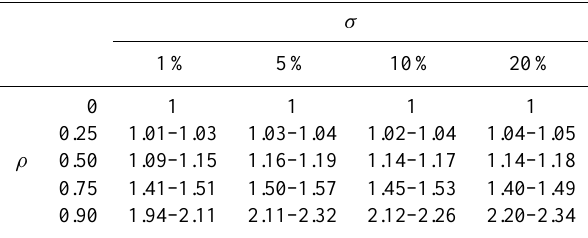
Table 3. Reference table showing the 95% confidence interval for the median Bayes factor. The correlation coefficient ρ and the stan- dard deviation of the marginal distributions σ are shown.